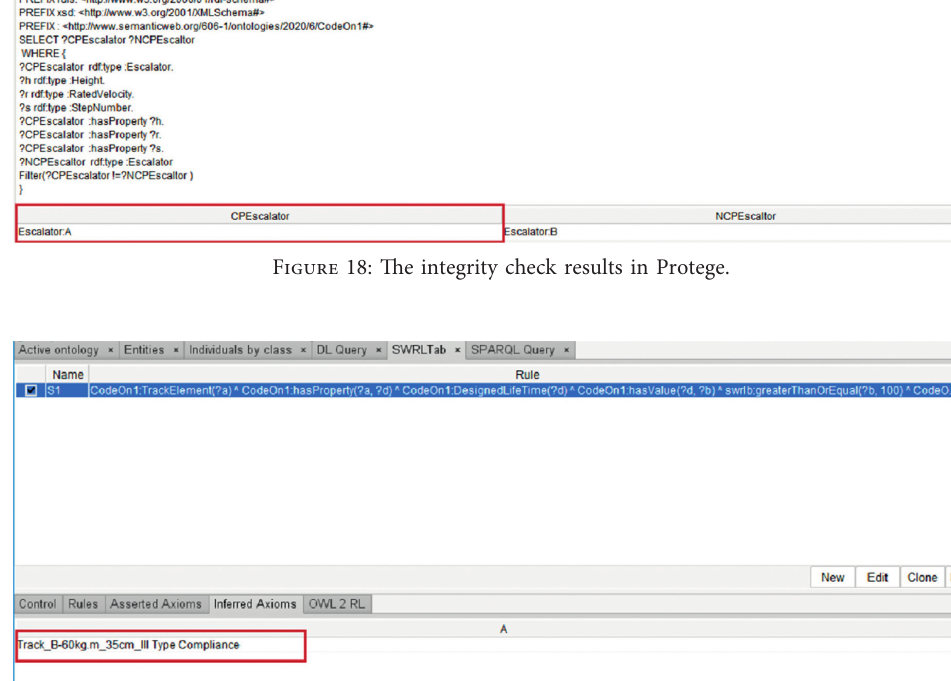
Figure 19: The compliance check results in Protege.